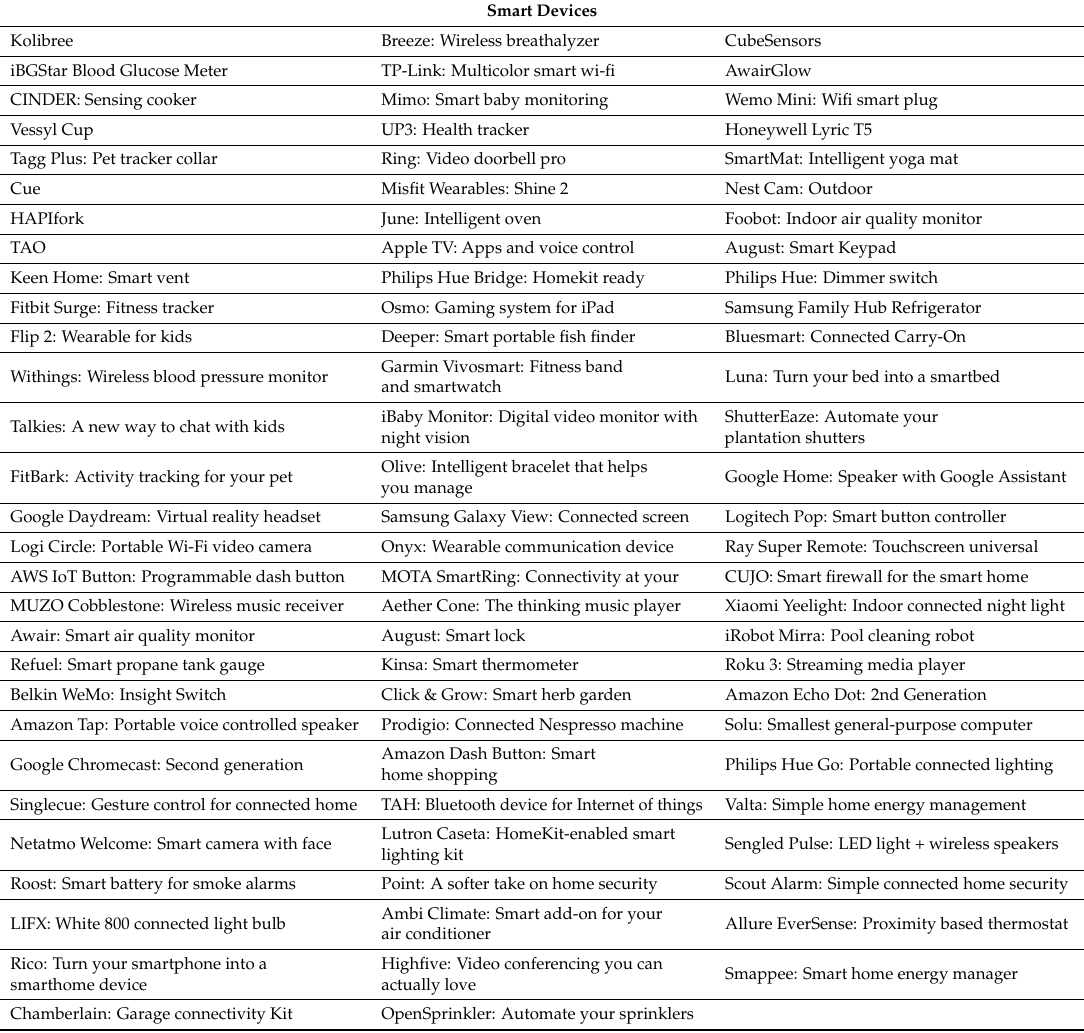
Table A1. List of smart devices revised durin the development of this